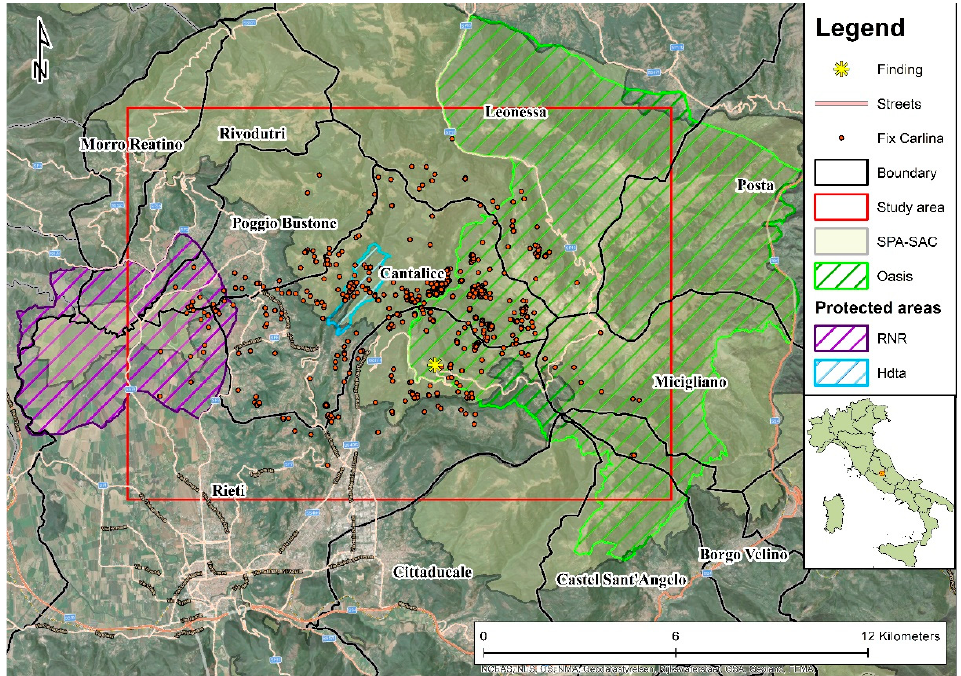
Figure 1. Study area, location of finding/releasing and Carlina locations (Fix). Boundary = municipalities boundaries; SPA = special protection area (EU Birds Directive 2009/147/EC); SAC = special area of conservation (EU Habitats Directive 92/43/EEC); RNR = regional natural reserve “Laghi Lungo e Ripasottile”; Oasis = Terminillo wildlife oasis; Htda = hunting dog training area. The locality where Carlina was found, unable to move, on 21 July 2013 is Lisciano (RI). The climate is typical of the band temperate region. The central Apennines are characterized by the inferior subalpine thermotype with beech woods and shrubs, a Juniperus alpina , Vaccinium myrtillus and Arctostaphylos uva ‐ ursi ; by the lower mountain thermotype with beech woods and woods dominated by Ostrya carpinifolia ; and by upper hill thermotype with hop hornbeam ( Ostrya carpinifolia ), mixed woods and oaks to Quercus spp. [19]. Forests cover over half of the territory, where deciduous and conifer woods represent 55.8% and 3.3%, respectively, while 13.4% is represented by natural grassland and pastures. Roads and human settlements cover 10% of the total study area (Table 1). Table 1. Land ‐ covers of the study area.